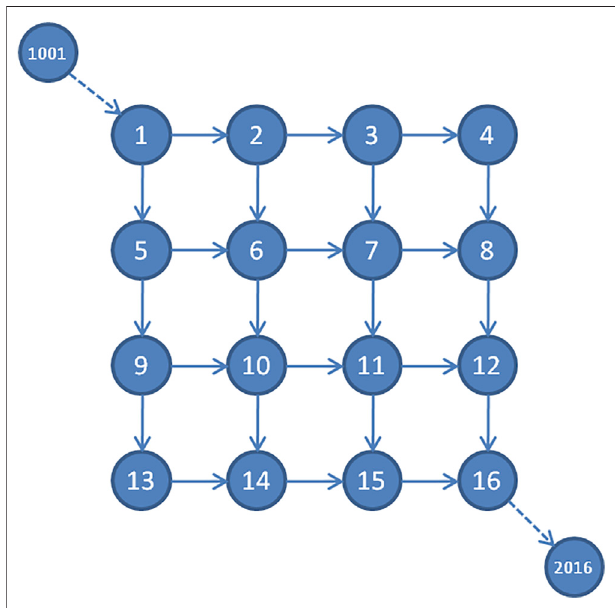
FIGURE 1 | Considered test network.